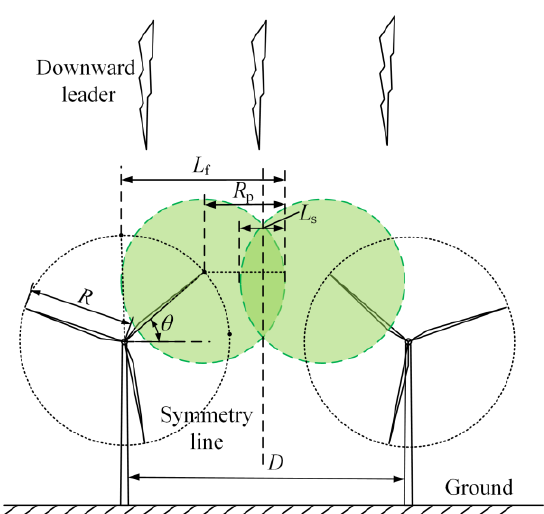
Figure 1. Mutual shielding of two adjacent turbines.